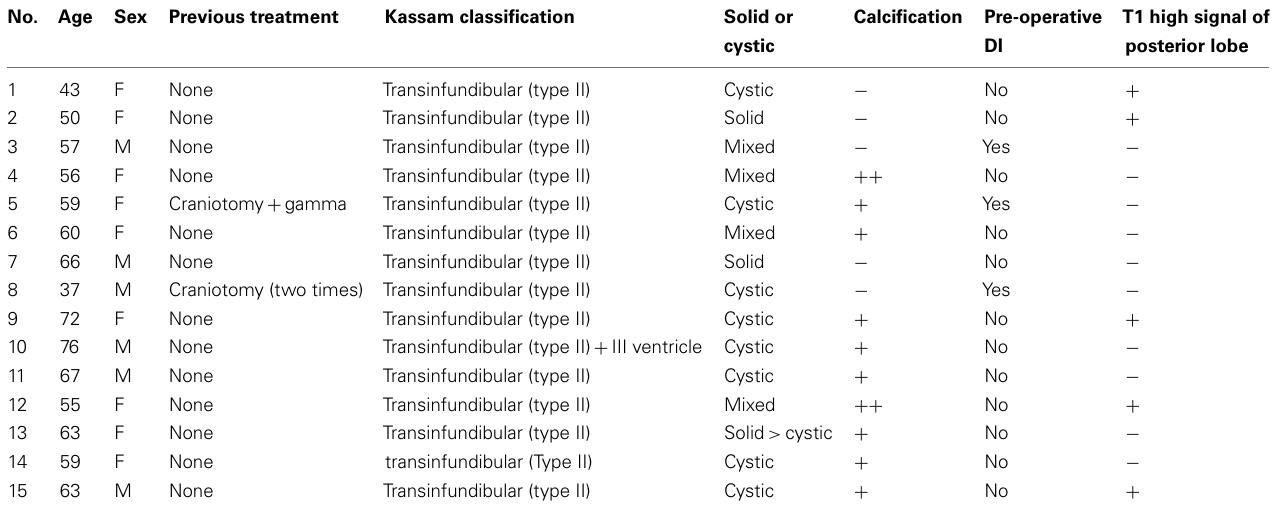
Table 1 | Clinical and radiological findings in 15 patients with craniopharyngioma treated using endoscopy-assisted extended microscopicTSS. No. Age Sex Previous